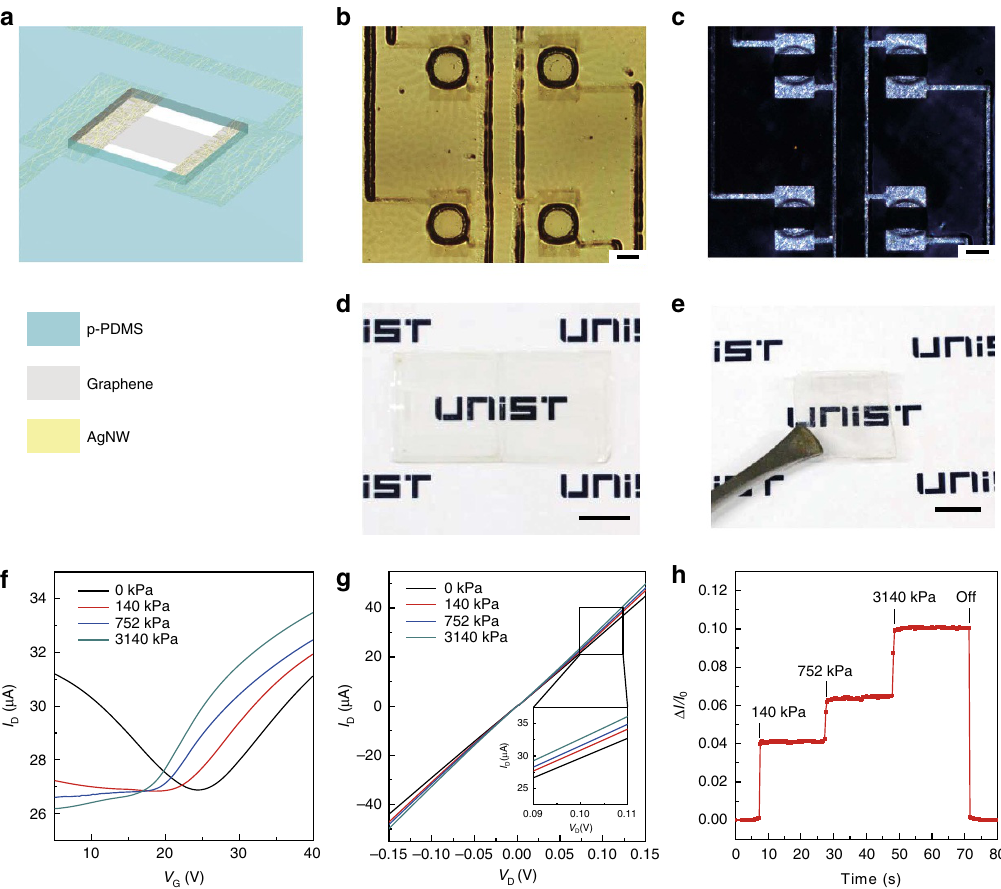
Figure 4 | Fabrication and characterization of transparent pressure sensor. ( a ) Schematic illustration for the structure of transparent pressure sensor. ( b , c ) Optical microscopy images for FETs using AgNW-graphene hybrid electrodes with bright field and dark field, respectively. The holes forming air-dielectric layer can be identified in both images. Scale bars, 200 m m. ( d , e ) Transparent pressure sensor sample images before and after folding the substrate, respectively. The entire device including the substrate has the transmittance of B 82% at a wavelength of 550nm. Scale bars, 1cm. ( f ) Transfer characteristics under different amount of applied pressure. It shows similar electrical behaviour with the non-transparent pressure sensor using Cr/Au electrodes ( V D ¼ 0.1V). ( g ) Output characteristics ( V G ¼ 35V). ( h ) Real-time measurements of normalized drain current changes for applied pressures at V D ¼ 0.1V and V G ¼